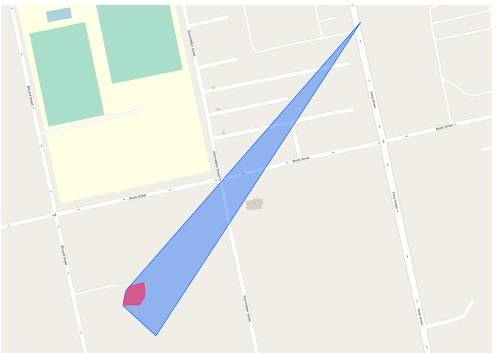
Figure 20. Backtracking a cell-renaming operation. The two original cells are shown in red and